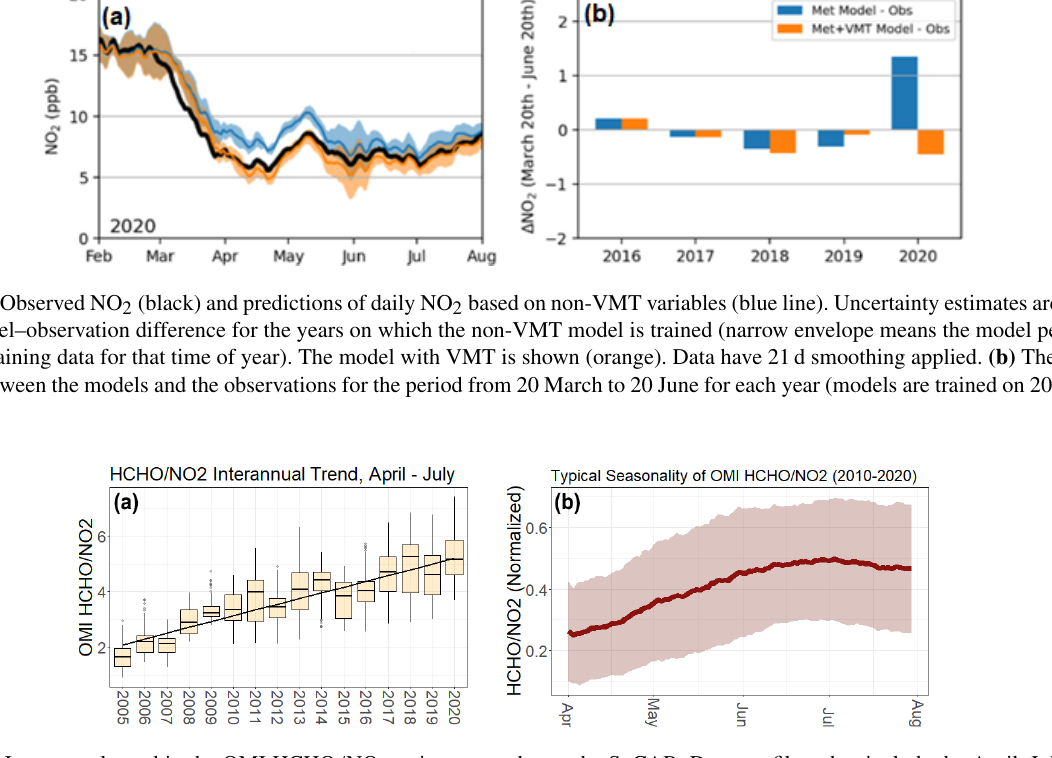
Figure 5. (a) Interannual trend in the OMI HCHO / NO 2 ratio averaged over the SoCAB. Data are filtered to include the April–July period of each year. A linear fit is applied to the data. (b) Typical seasonality of OMI HCHO / NO 2 averaged over the SoCAB. Data have been normalized to the range for each